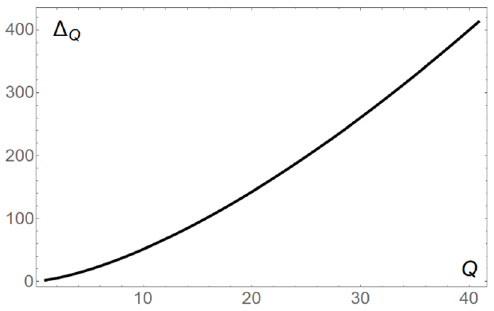
Figure 1. The numerical result of M ( Q AdS ) = (cid:1) Q ( Q ) along the soliton branch q 2 = 1 :